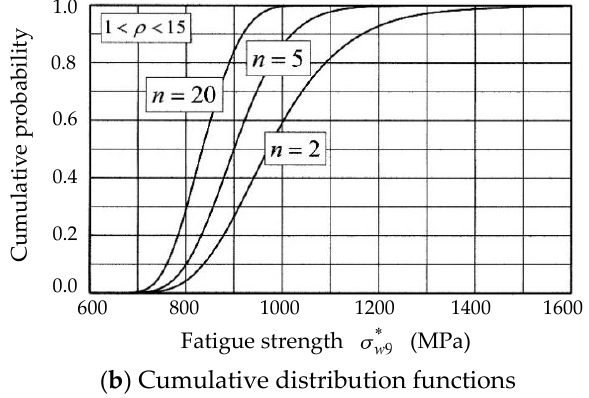
Figure 8. Distribution patterns of fatigue strength.